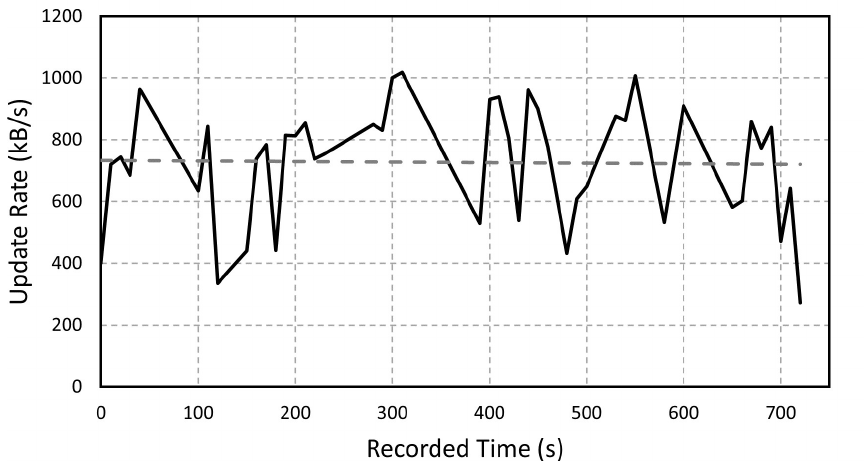
Figure 6. Average data transfer speed over time. The solid line represents the measured values and the dashed line represents the average value.